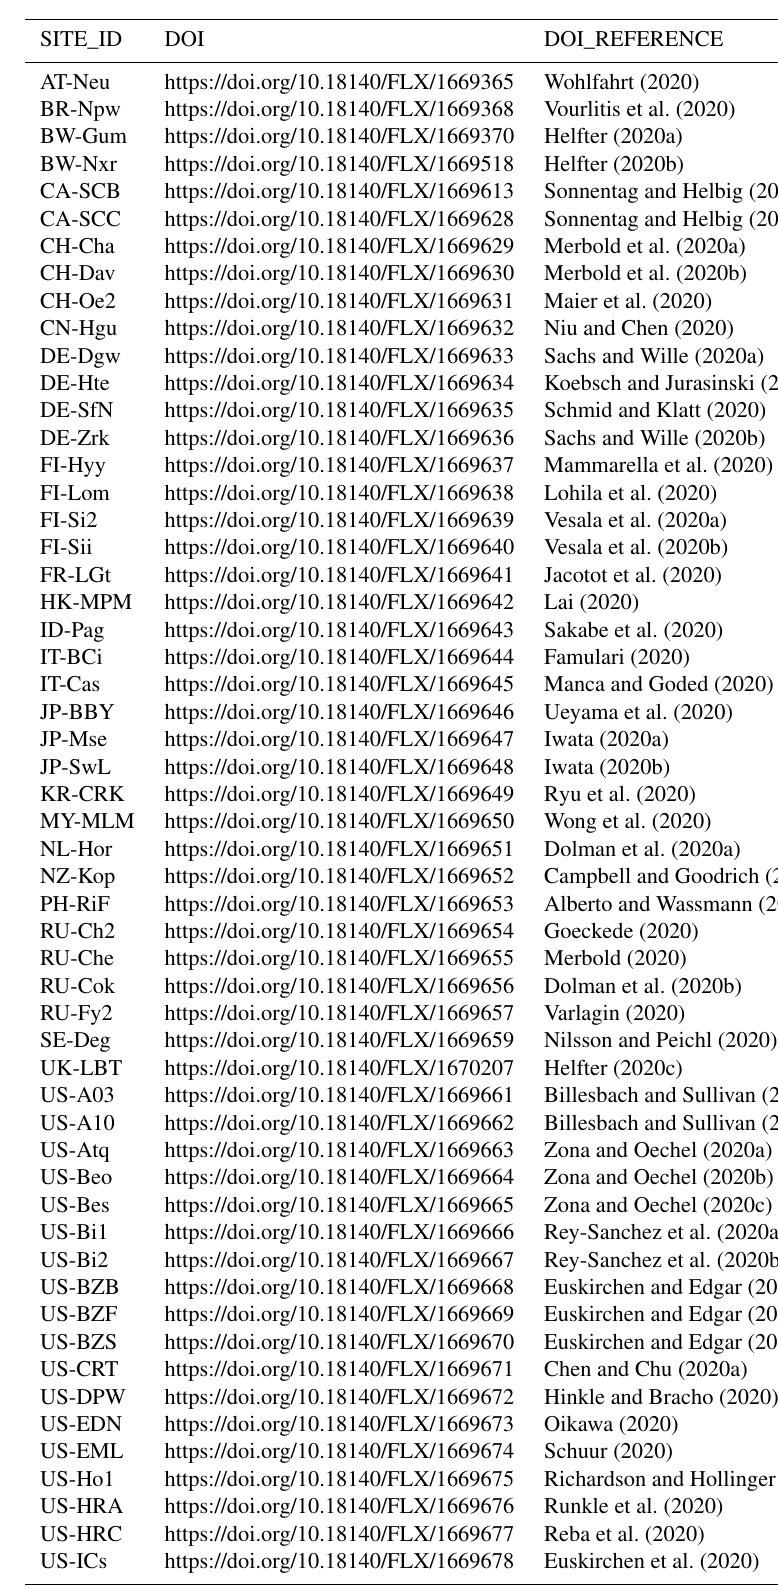
Table 2. Site identification (SITE_ID), data DOI, and DOI reference for each FLUXNET-CH 4